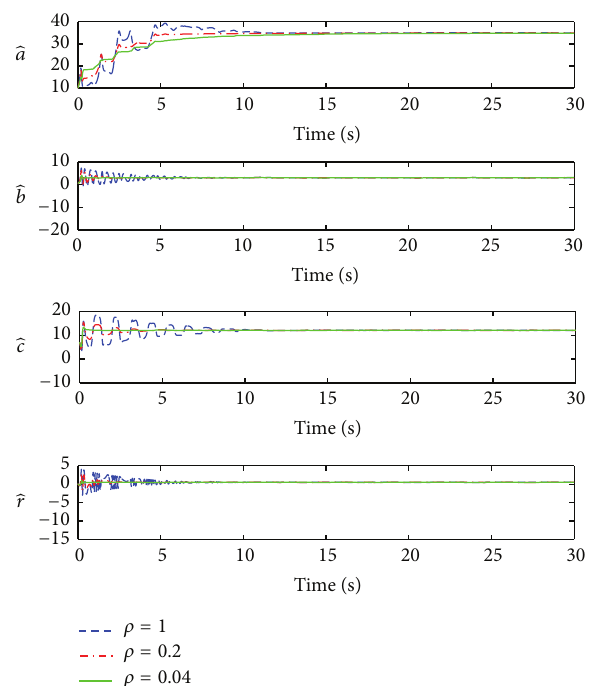
Figure 1: The estimated values of the unknown parameters 𝑎 1 , 𝑏 1 , 𝑐 1 , and 𝑟 1